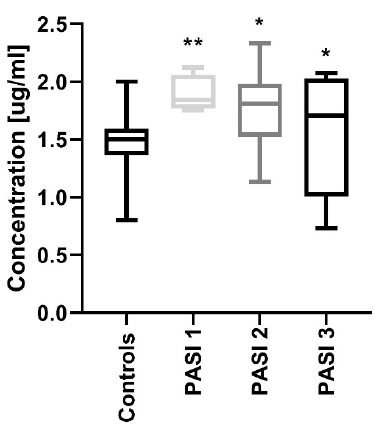
Figure 2. Comparison between PCSK9 concentrations depending on the psoriasis area and the severity index (PASI) before treatment and controls. */** means statistical significance with p < 0.05/0.01 respectively, compared to Controls.